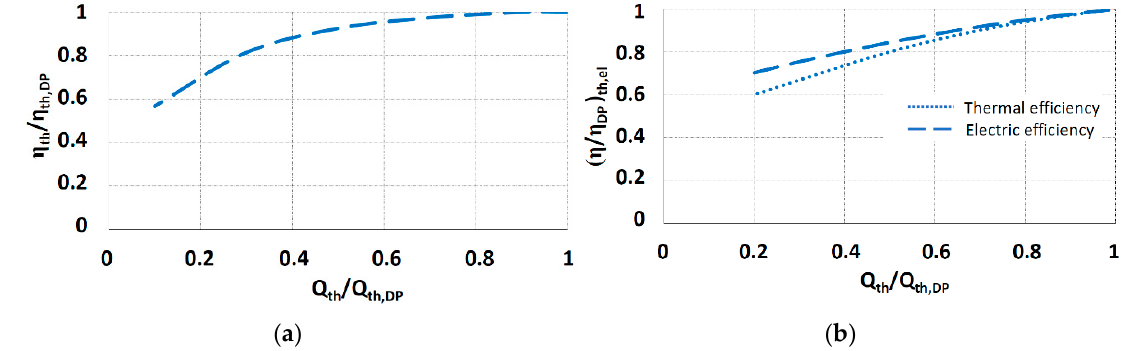
Figure 10. Trend of the thermal/electric efficiency resized using the design point values against the part-load thermal power needed by the preheating process of ( a ) gas-fired heaters and ( b ) cogenerative internal combustion engines (CHP-ICE).